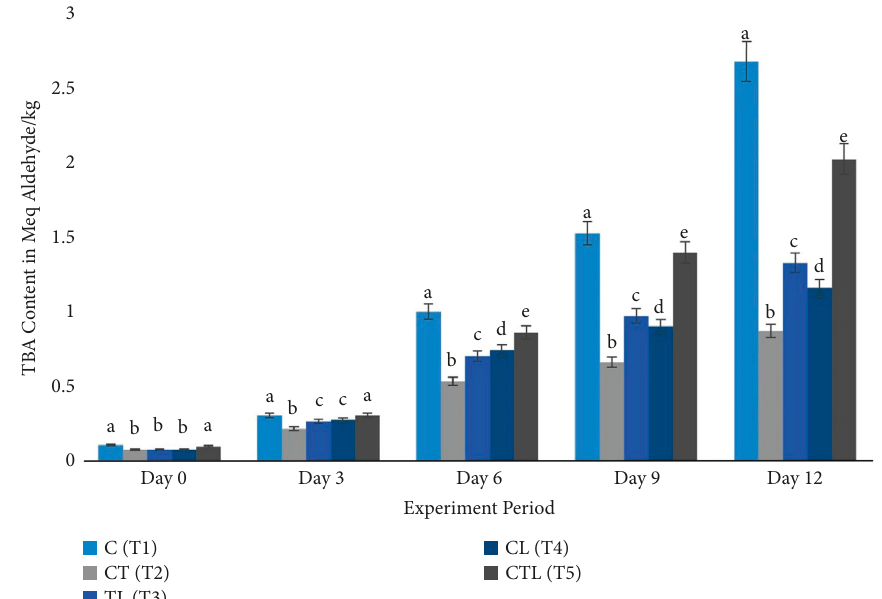
Figure 7: TBA content in the carp fillet immersed in mixed different extracts of turmeric, cinnamon, and lemon at 4 ° C.